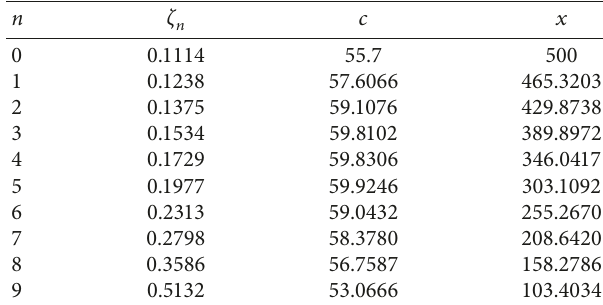
Table 3: Evolution of optimal consumptions and wealth processes